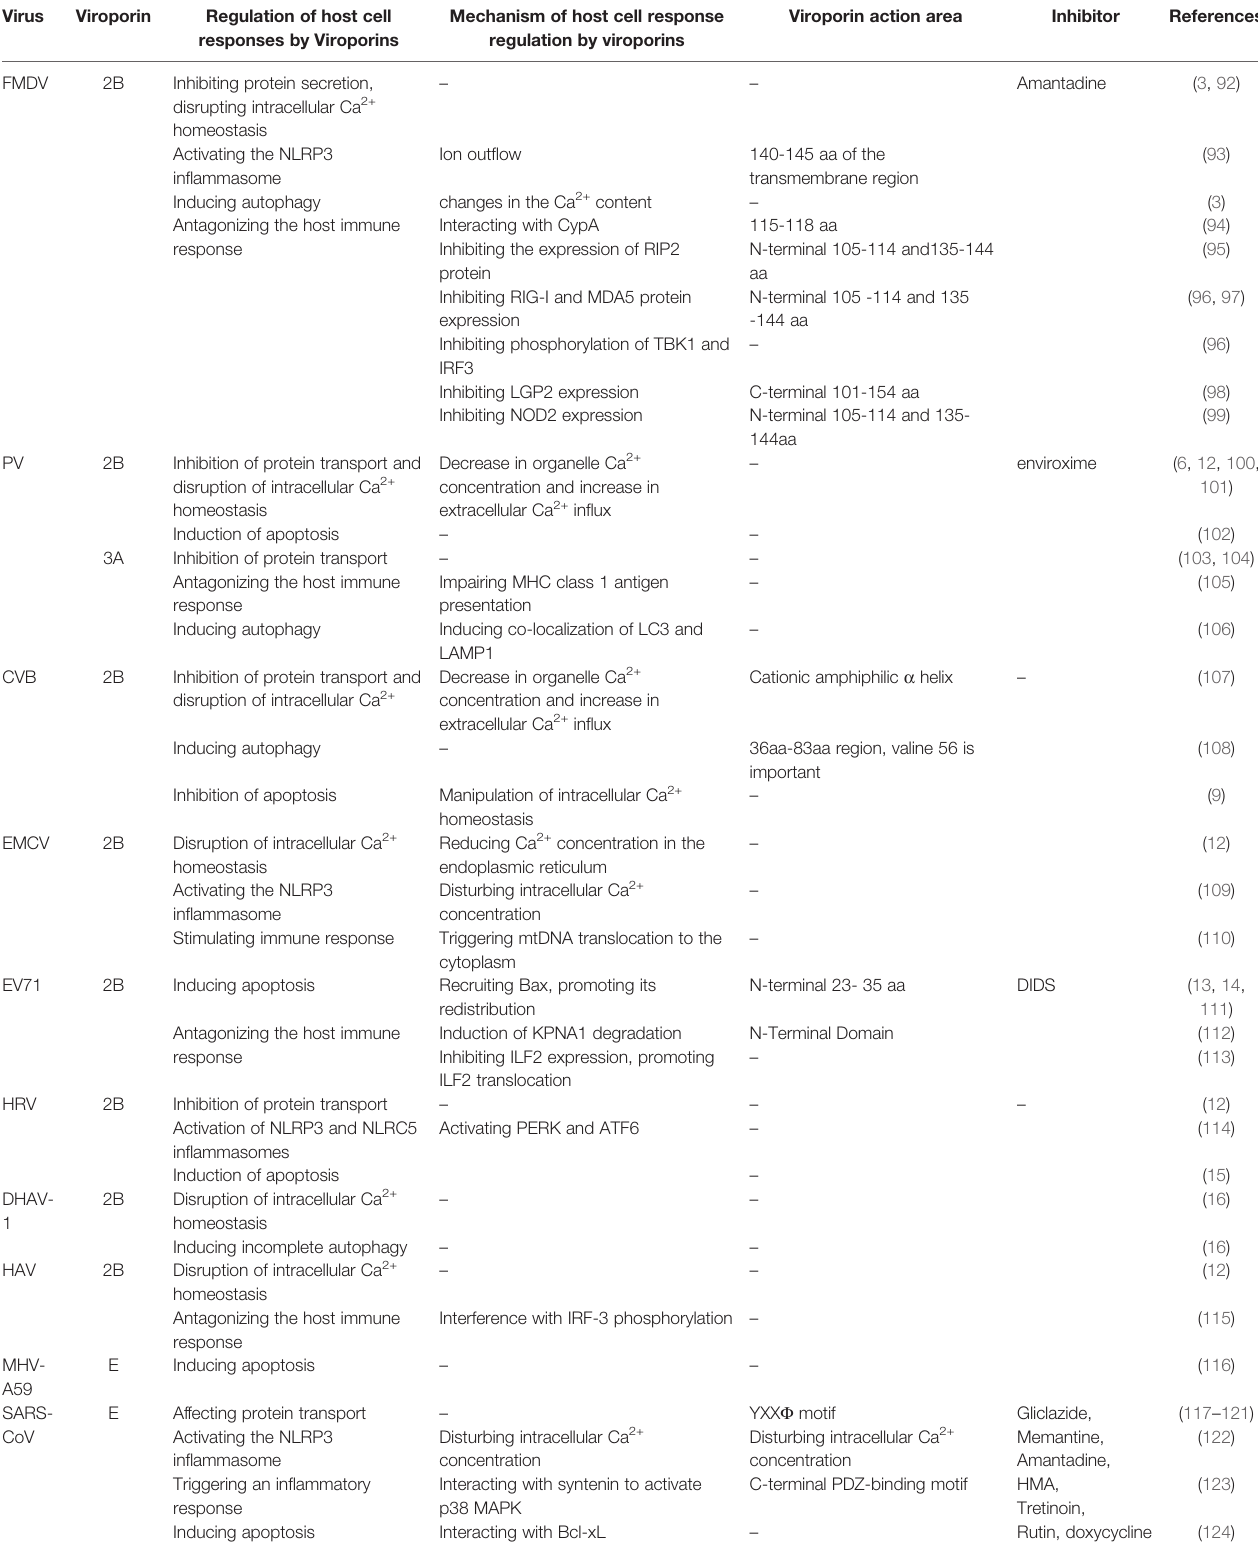
TABLE 2 | Regulation of host cell responses by viroporins.